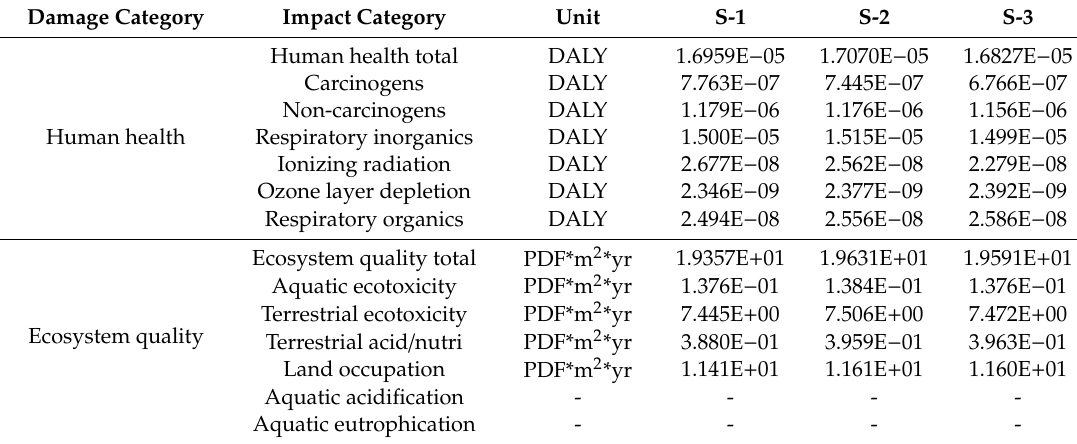
Figure 7. Endpoint life cycle impacts, i.e., damages via municipal solid waste management (MSWM)systems based on S1–3. Table 2. Damage assessment results, i.e., endpoint life cycle impacts of studied municipal solid waste (MSW)systems based on